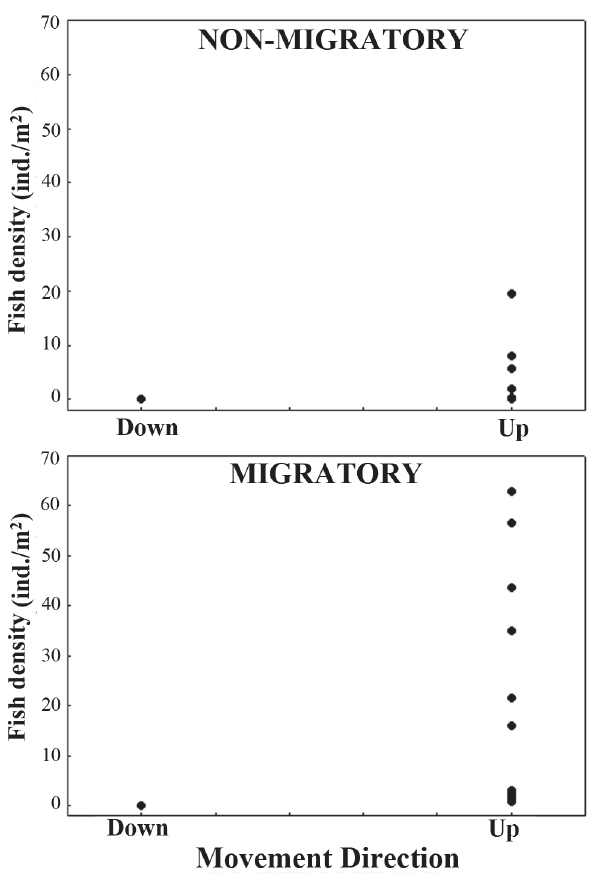
Fig. 5. Ratio between the number of fish (ind./m 2 ) ascending and descending through the ladder (UP/DOWN), between September 2009 and August